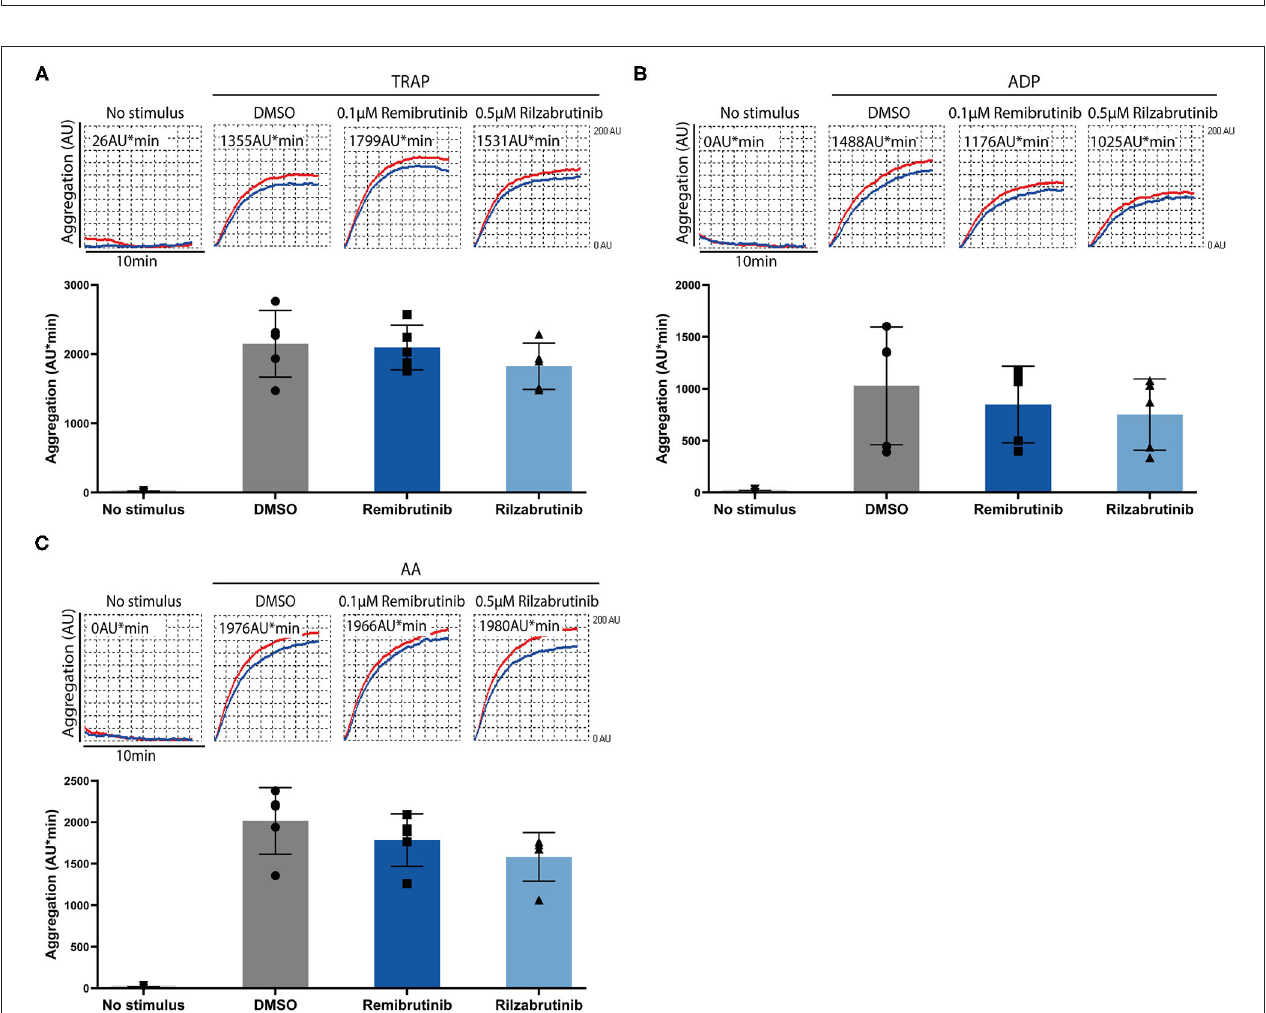
FIGURE 2 | or (E) anti-CD9 antibody (1 µ g/ml). Representative MEA tracings (top panels) and bar graphs (bottom panels) are shown. Values are shown as mean ± SD ( n = 5). Statistical analysis was carried out using ordinary one-way ANOVA followed by Bonferroni’s test (B,D) or Kruskal-Wallis followed by Dunn’s test (A,C,E) .